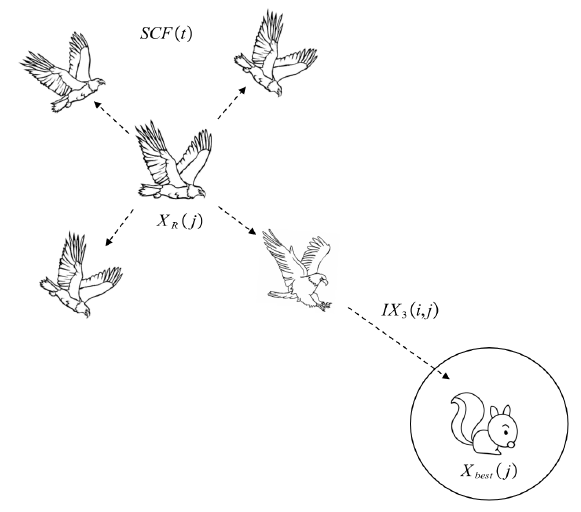
Figure 2. Aquila search around prey and